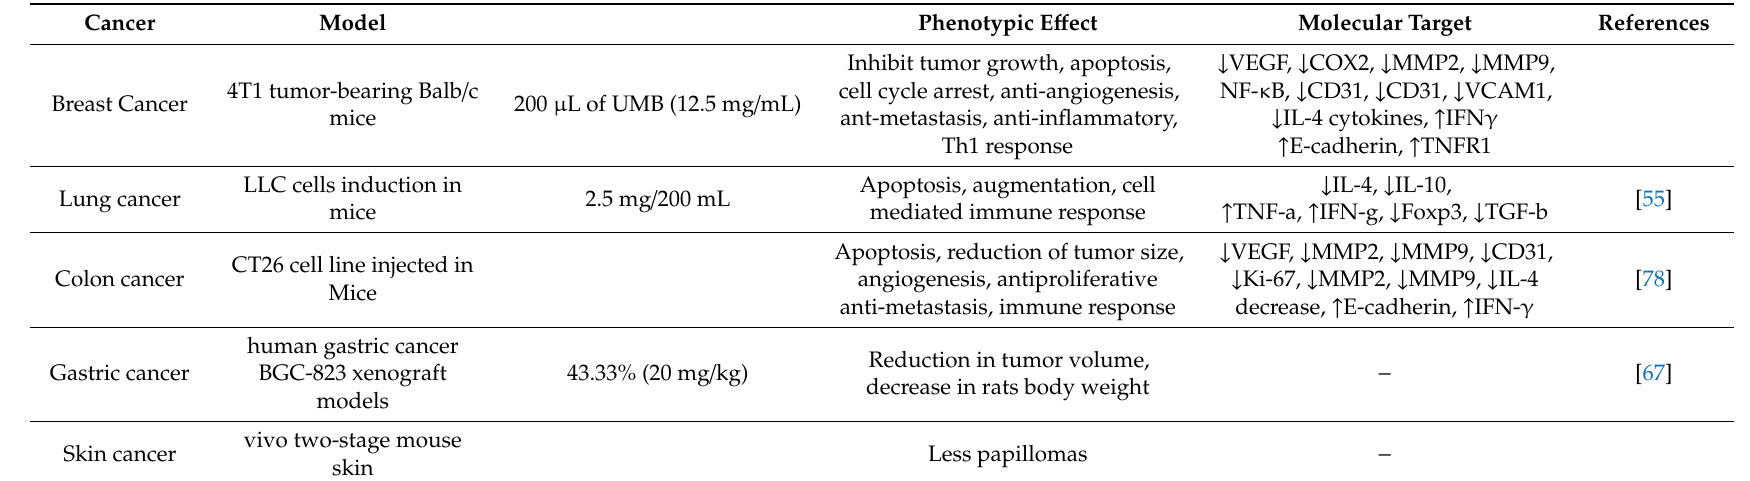
Table 2. In vivo anticancer e ff ects of